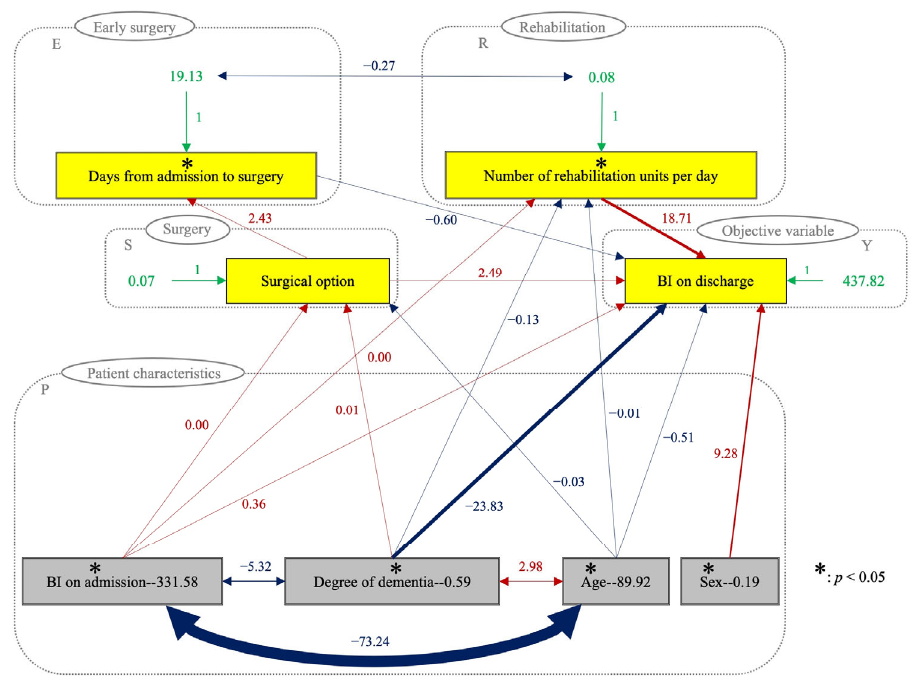
Figure 2. Structural equation modeling with the following conditions: R 2 , 0.65; CFI, 0.99; GFI, 0.98; AGFI, 0.94; and RMSEA, 0.06. The CFI, GFI, AGFI, and RMSEA indicate a good model fit. One ‐ directional arrows indicate causality and two ‐ directional arrows indicate correlation between the variables. Red arrows indicate positive correlation, blue arrows indicate negative correlation, and green arrows indicate the error variance, while line width is proportional to effect. CFI, comparative fit index; GFI, goodness ‐ of ‐ fit index; AGFI, adjusted goodness ‐ of ‐ fit index; RMSEA, root mean square error of approximation. Table 4. Direct effect, indirect effect, total effect, and p ‐ value.